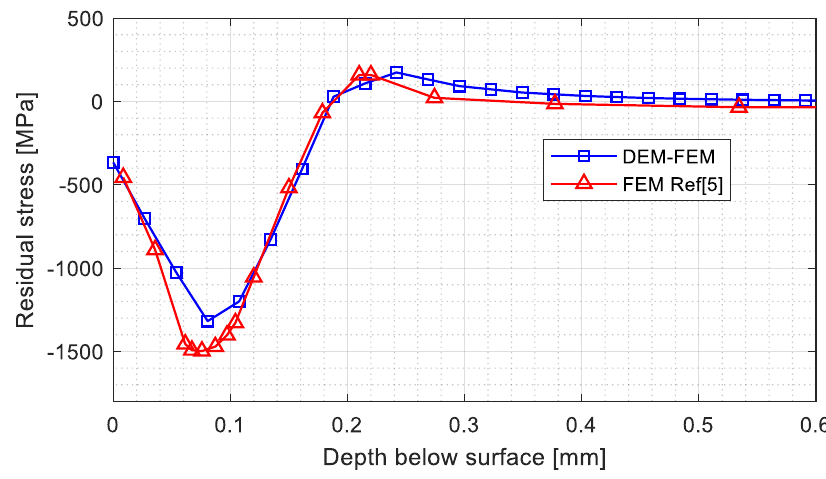
of Inco718. Showing the current DEM-FEM result and FEM result recreated from the literature [29].